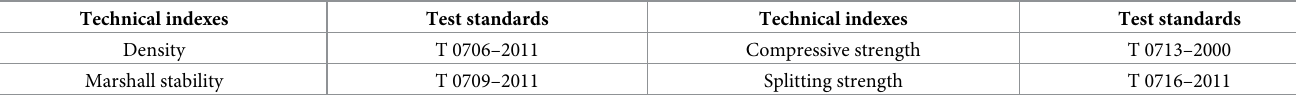
Table 7. Test standards of technical indexes.